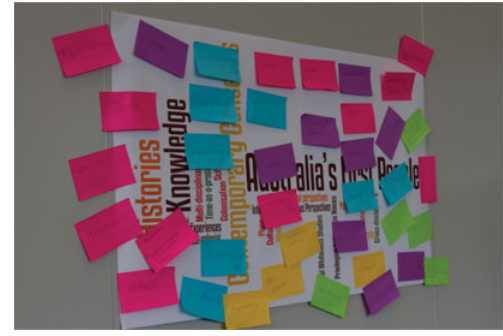
(Colour online) Initial Word Cloud: ‘What is Indigenous Studies?’, October 25, 2013.